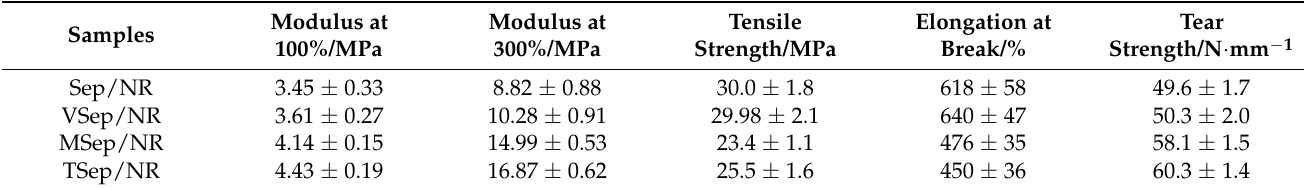
Table 5. Static mechanical properties of sepiolite/NR